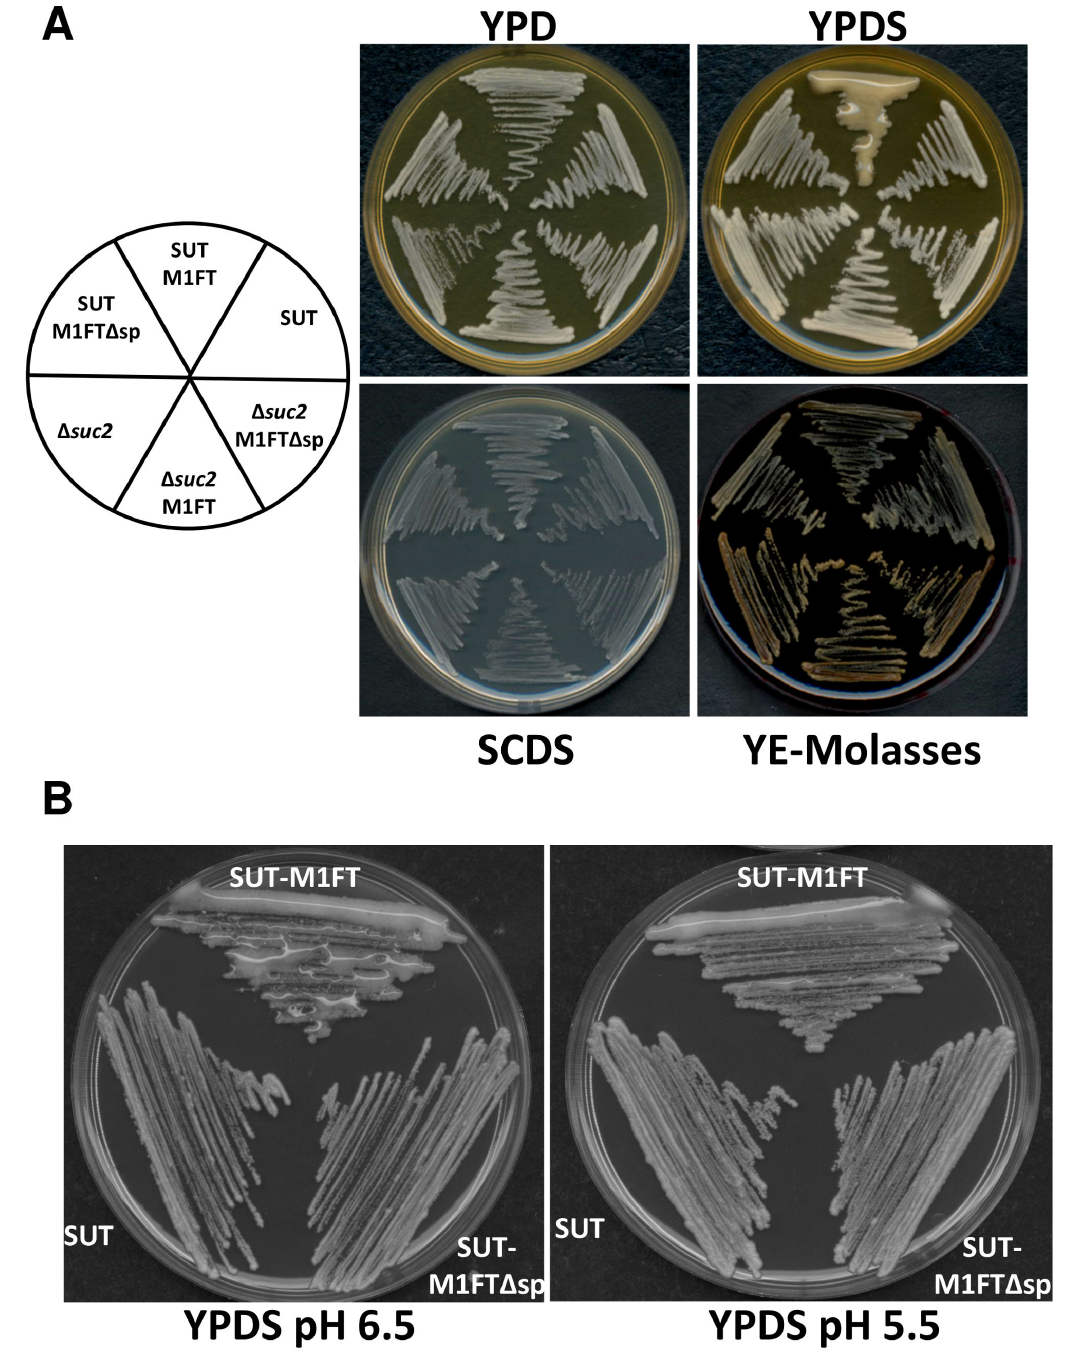
Figure 6. Extracellular polysaccharide (EPS) production by the M1FT expressing strains. (A) Slime production by the BY4742Δ suc2 -SUT-M1FT yeast strain is dependent on growth medium. Cultures where grown on either rich media without sucrose (YPD), rich media with sucrose (YPDS), minimal media with sucrose (SCDS) or media containing 1% yeast extract and molasses, which was diluted to provide the same sucrose (5%) concentration as YPDS (YE-Molasses). Slime is only visible on rich media containing sucrose (YPDS). (B) The effect of pH on extracellular polymer accumulation. The production of levan as an extracellular polysaccharide (EPS) is reduced when the pH of the growth medium (YPDS) is changed from pH 6.5 (the unadjusted pH of YPDS) to pH 5.5 (which is the same as the pH of the SCDS media). Plate pictures are a representative of observations confirmed by at least three separate biological repeats. doi: 10.1371/journal.pone.0077499.g006 PLOS ONE |